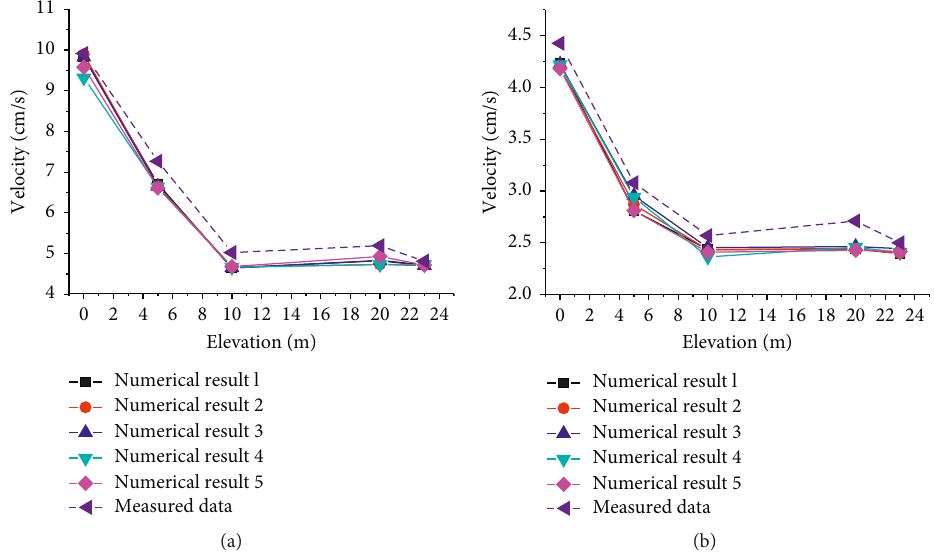
Figure 7: Comparison of the vibration velocity of numerical simulation in the elevation direction with the measured data and the calculated results. Horizontal distance of (a) 10 m and (b) 20